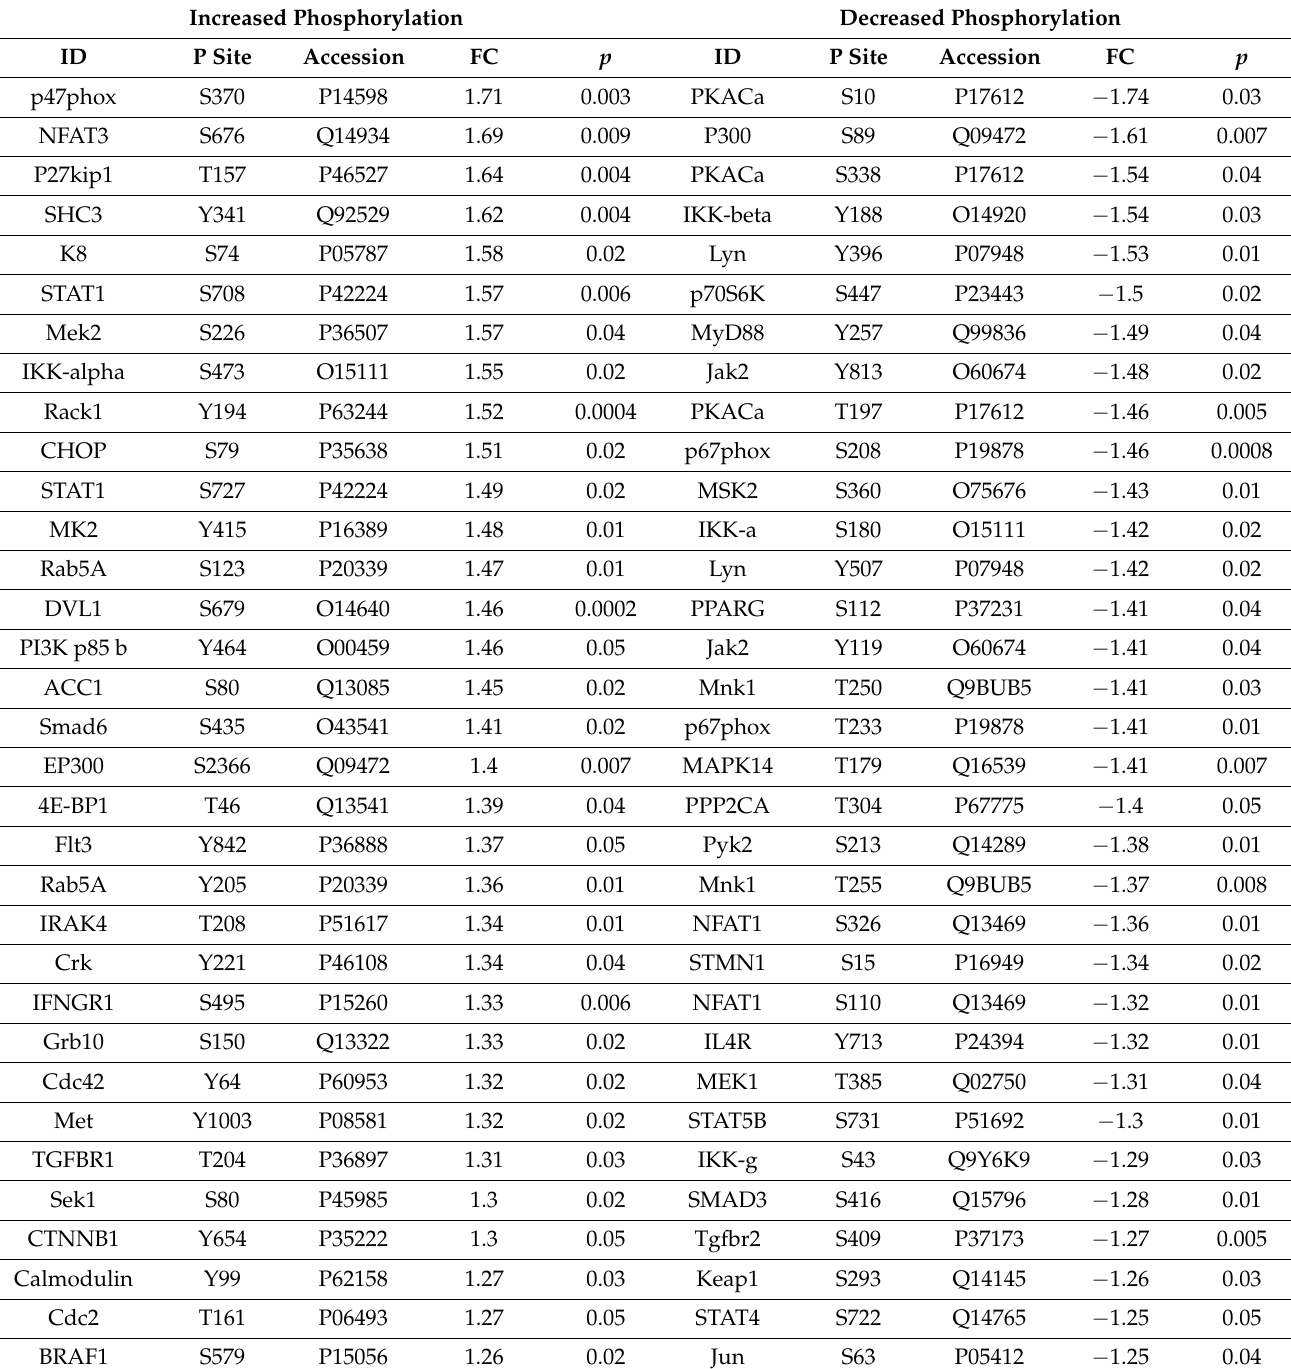
(Table 6). The small number of differential phosphorylated peptides at the lymph nodes in response to alum negates the ability to perform pathway analysis. Table 4. Differentially Phosphorylated Peptides in Node in Response to